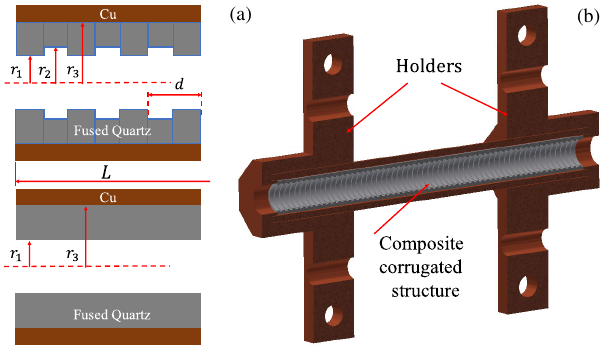
FIG. 1. Cross sections of corrugated capillary and capillary (a), cross section of corrugated mm-scale capillary with holders